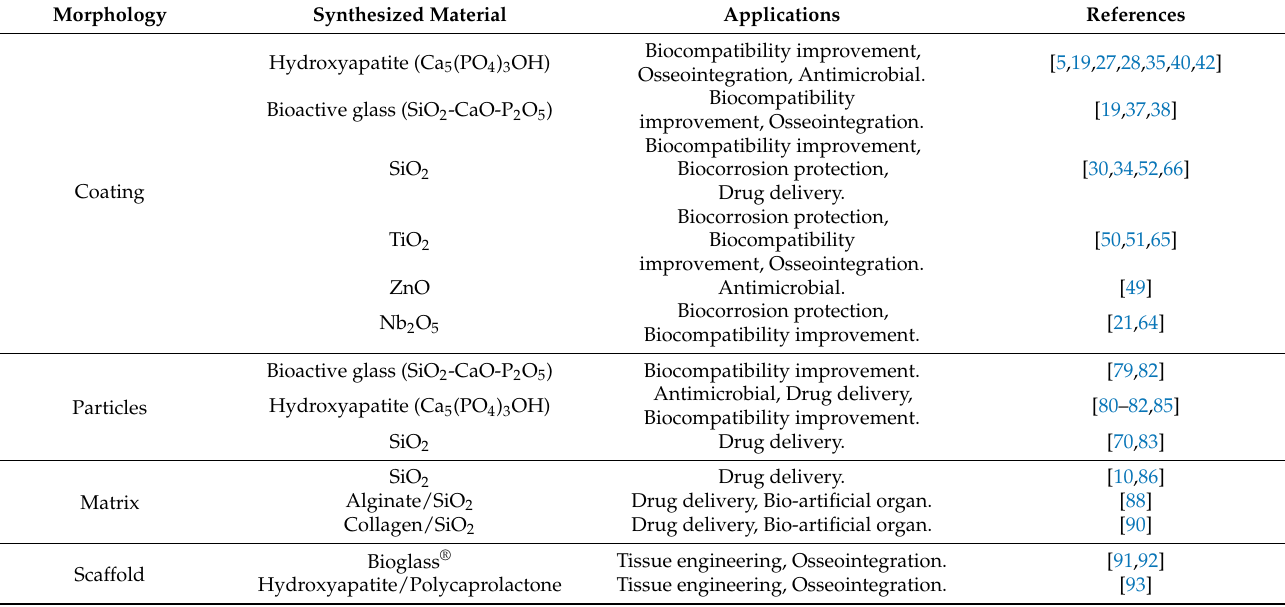
Table 2. Sol-gel synthesis method applied for the generation and development of biomaterials and tissue engineering